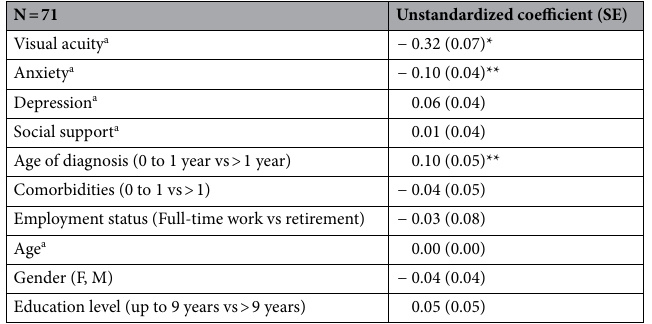
Table 3. Multivariate regression analysis to identify independent factors of patients’ health-related quality of life. F female, M male. * p < 0.001; ** p < 0.05. a Continuous variables.